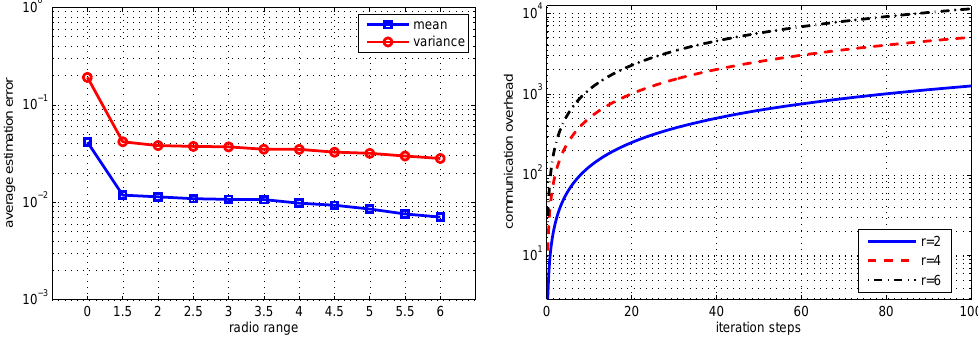
Figure 11. Estimated mean values versus radio